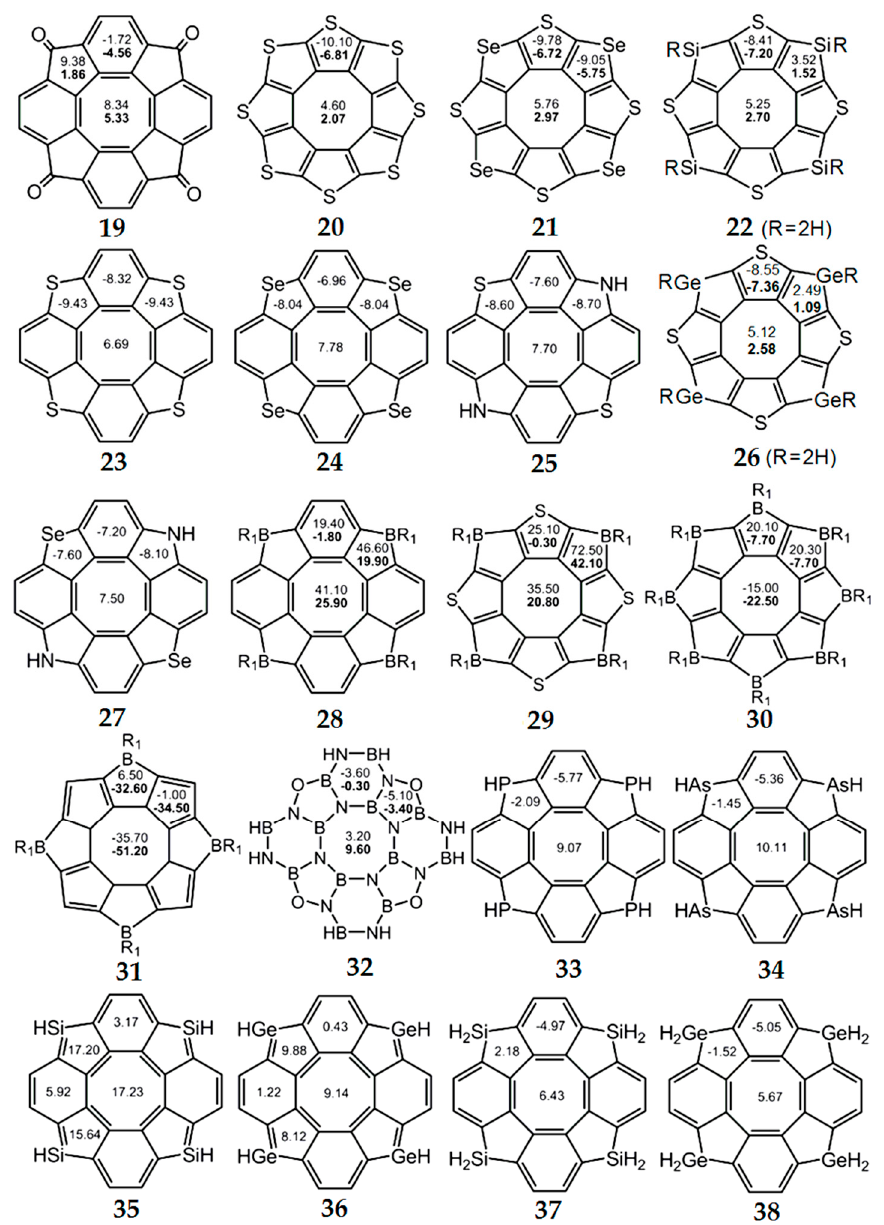
Figure 9. The values of NICS(0) (top number) and NICS(1) (bottom number in bold) indices for hetero[8]circulene molecules [33,34,74–81]. For planar molecules, NICS(0) and NICS(1) values are given, and for non-planar molecules, only NICS(0) values are shown.